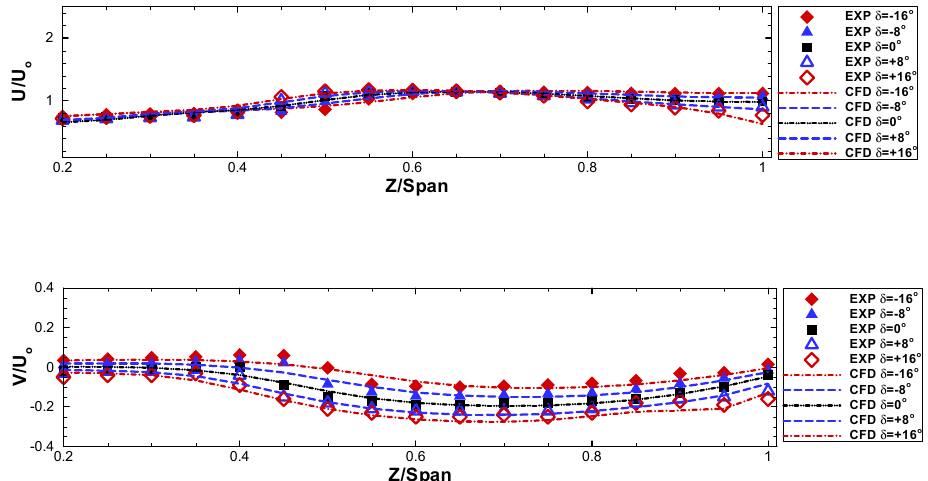
Figure 23. Velocity profiles of asymmetry-type rudder inflow obtained from experiment and numerical calculation.